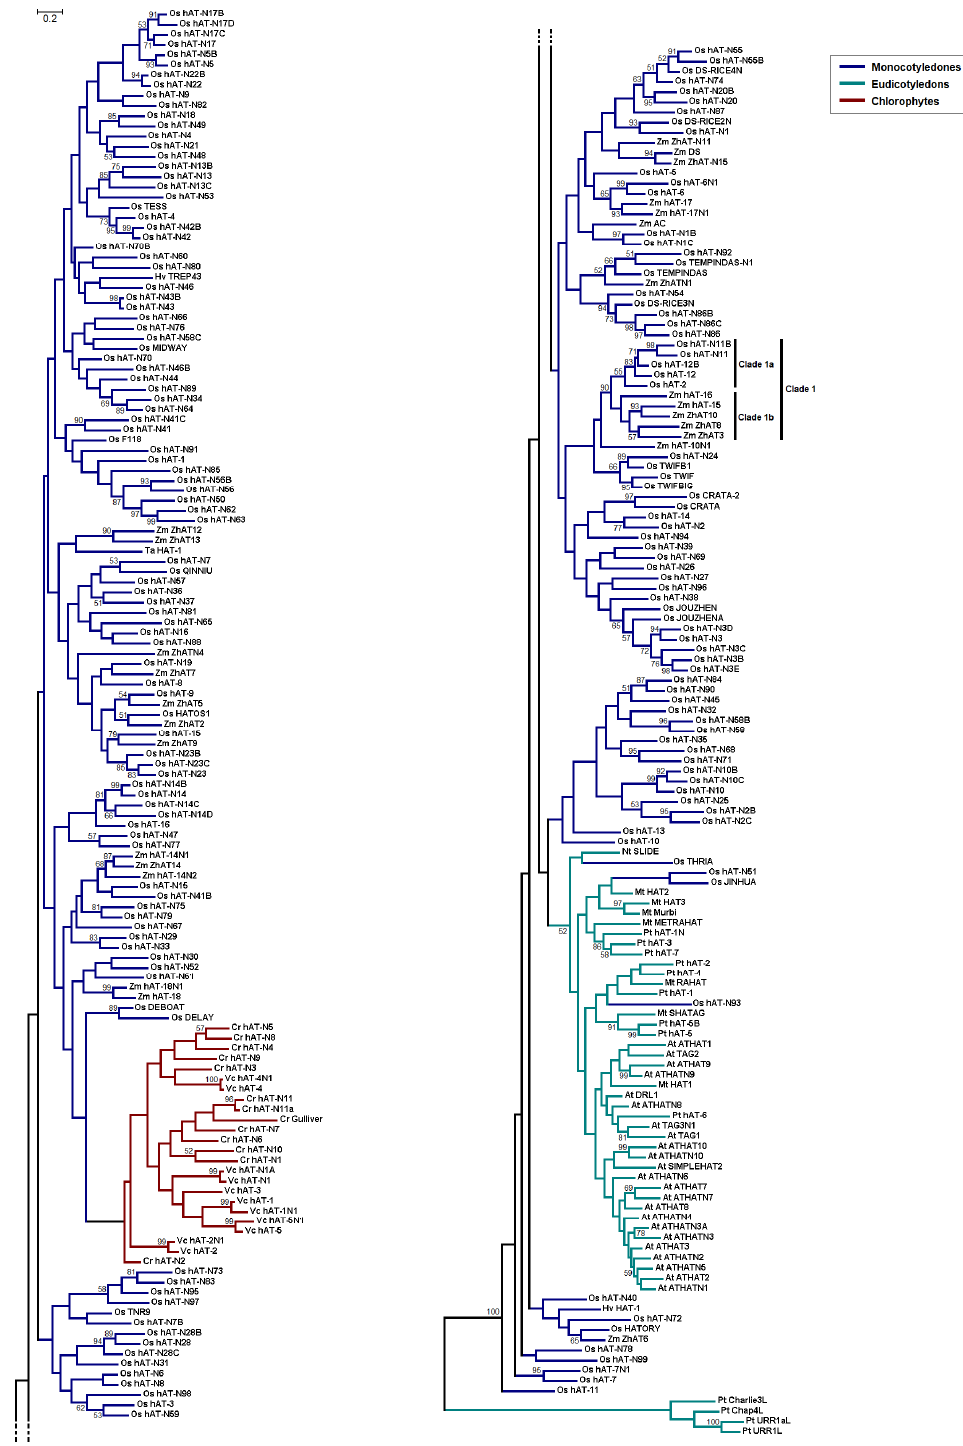
Figure 2. Unrooted maximum-likelihood (ML)-based tree of the plant hAT sequences. The tree is divided into two parts for clarity. Branch colors represent different taxonomic groups (insets). The conventions are the same as in Figure 1.